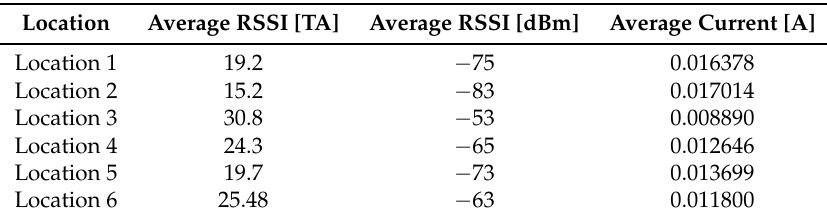
Table 10. Consolidated data for current consumption for all six locations.